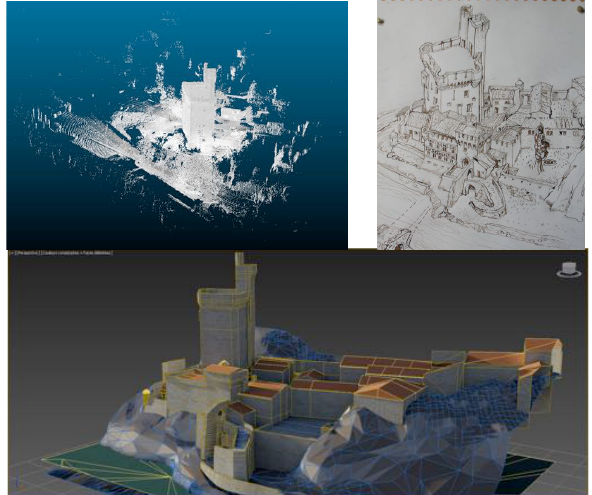
Figure 9. The 3D hypothetical reconstruction of the “Tour Philippe le Bel”, based on laser scanner surveying and